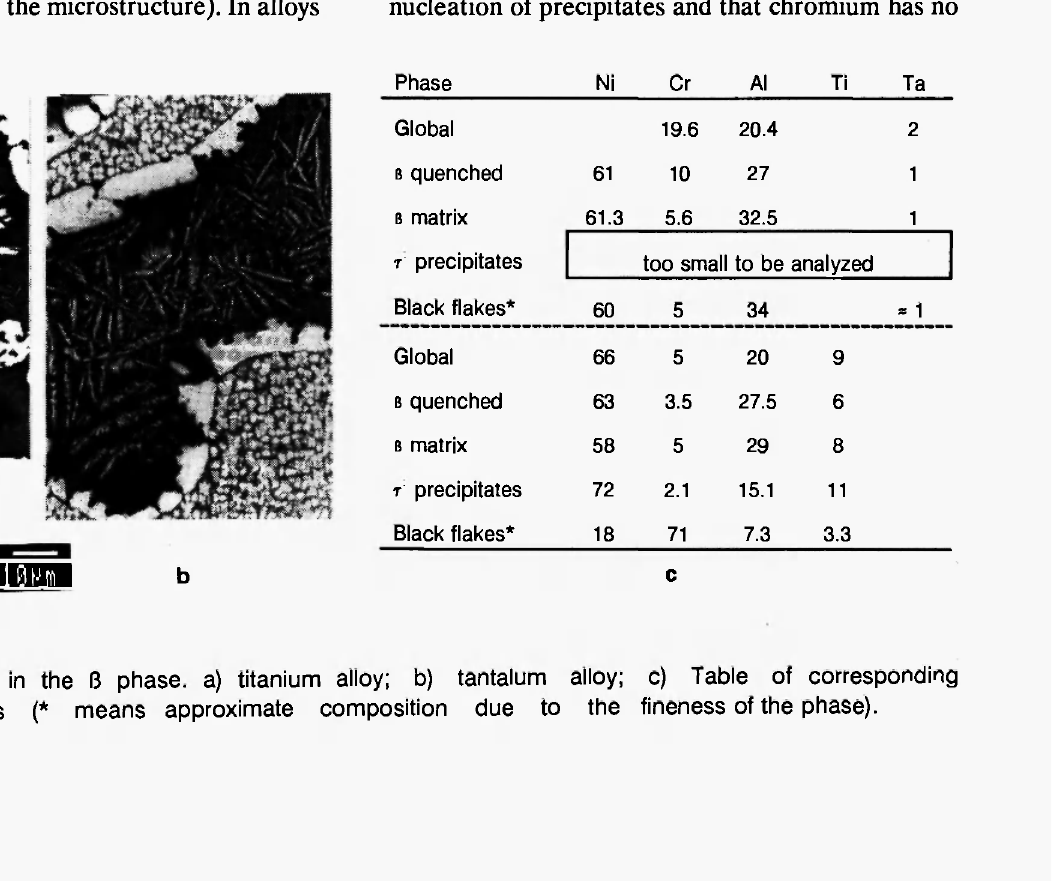
Fig. 10: Precipitation in the ß phase, a) titanium alloy; b) tantalum alloy; c) of corresponding compositions (* means approximate composition due to the fineness of the